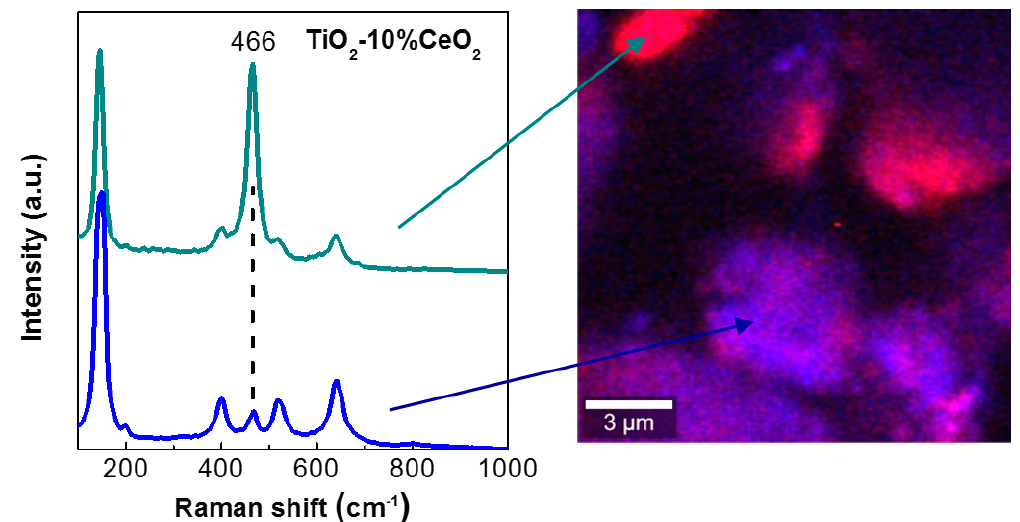
Figure 4. Confocal Raman mapping image of TiO 2 ‐ 10%CeO 2 sample.